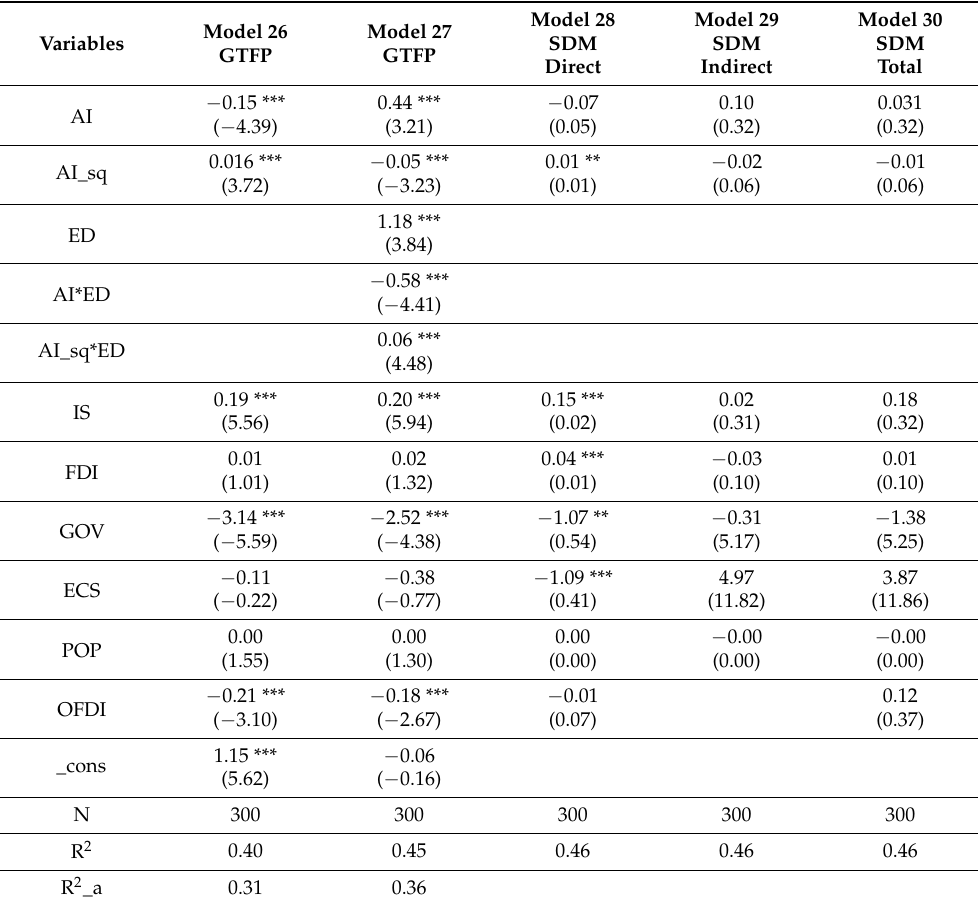
Table 10. Robustness test results—additional control